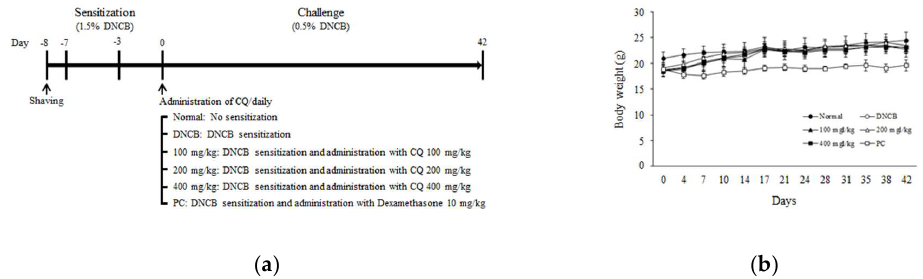
Figure 1. HPLC-DAD chromatogram (254 nm) of Combretum quadrangulare ethanol extract (CQ). Compounds are identified in the figure by number: 1 (tR = 7.92 min) – casuarinin, 2 (tR = 11.23 min) – isoorientin A, 3 (tR = 12.16 min) – orientin, 4 (tR = 14.13 min) – ellagic acid, 5 (tR = 44.21 min) – kamatakenin, 6 (tR = 45.12 min) – ayanin.